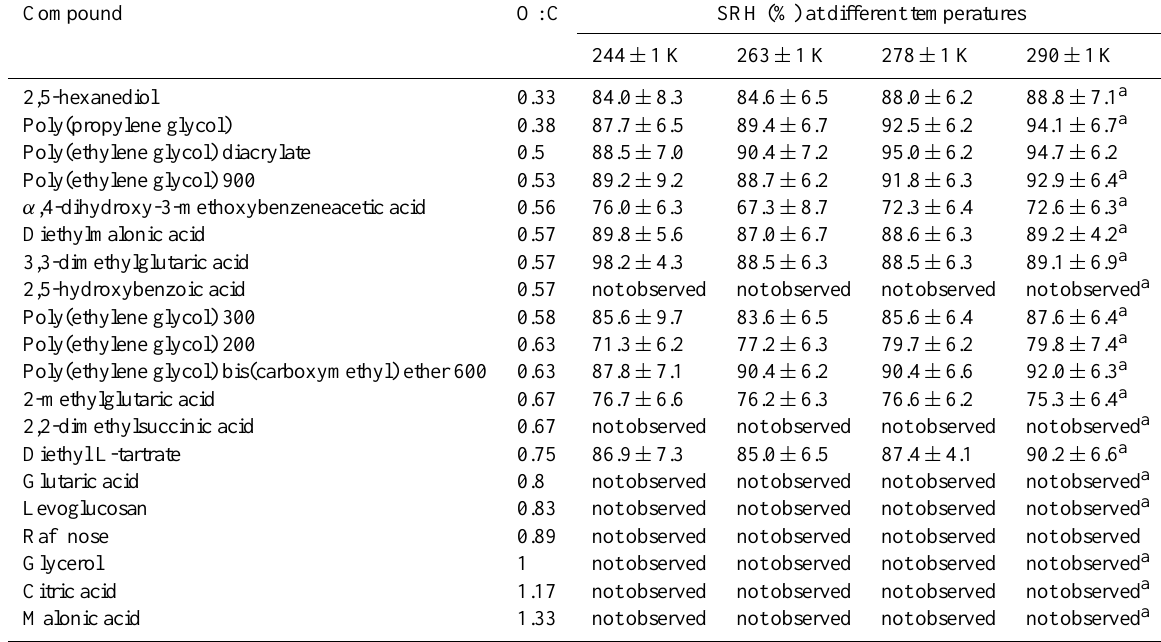
Table 4. Combined data set used to determine the effect of temperature on SRH. This includes the measurements at 244 ± 1K, 263 ± 1K, and 278 ± 1K in the current studies (Table 2) and results from You et al. (2013) at 290 ± 1K. OIR = 2.0 ± 0.1 in all the experiments. Uncertainties are 95% confidence intervals considering σ of multiple SRH measurements and the uncertainty from the calibration.